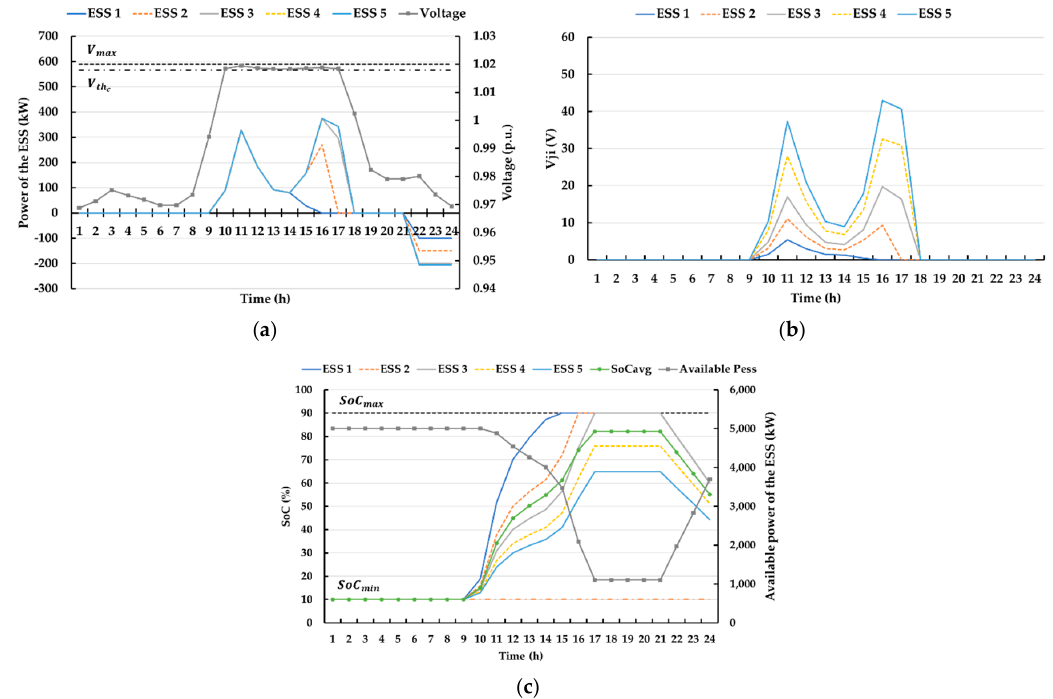
Figure 14. Voltage control results with ε : ( a ) Voltage profile and power of the distributed ESS; ( b ) V t ( c ) SoC profile.